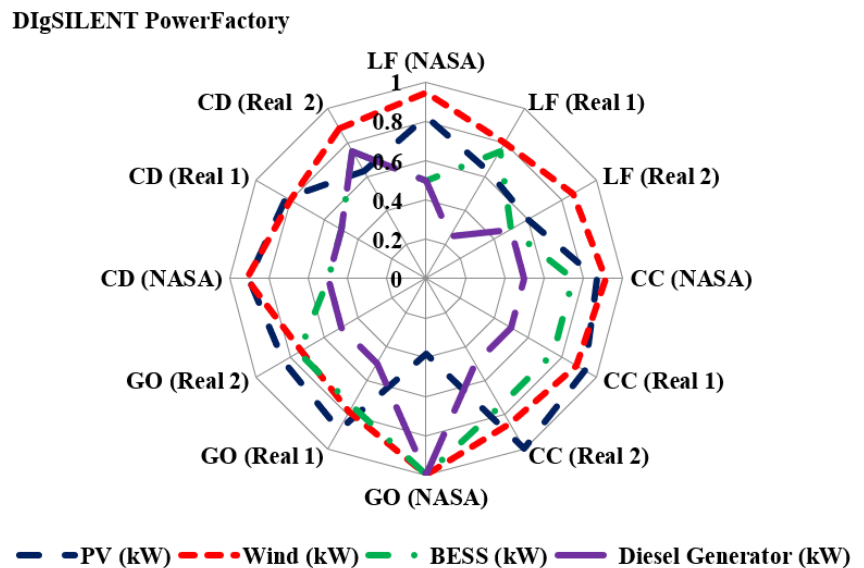
Figure 7. Comparison of optimal sizes (normalized) of each module from three different cases according to four dispatch strategies in DIgSILENT PowerFactory platform.